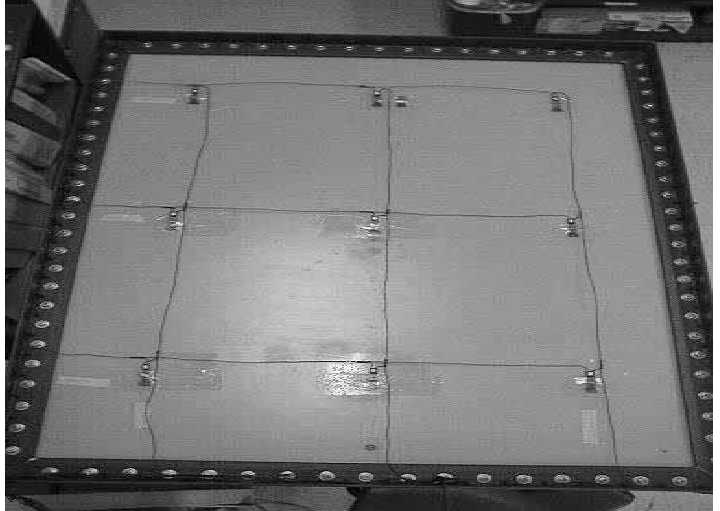
Fig. 16. Fiberglass panel with Cross Array Sensor Architecture.